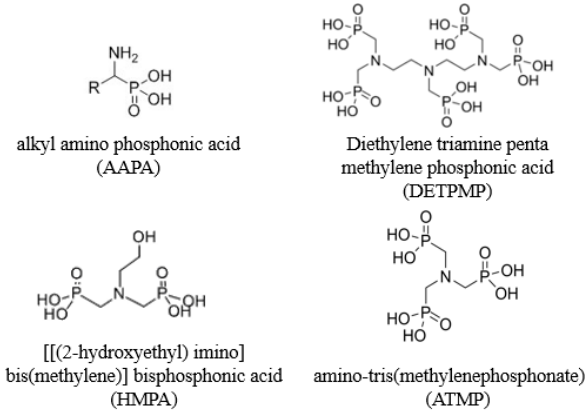
Figure 1. Generic structures of scale inhibitor organophosphorus used in dynamic systems.